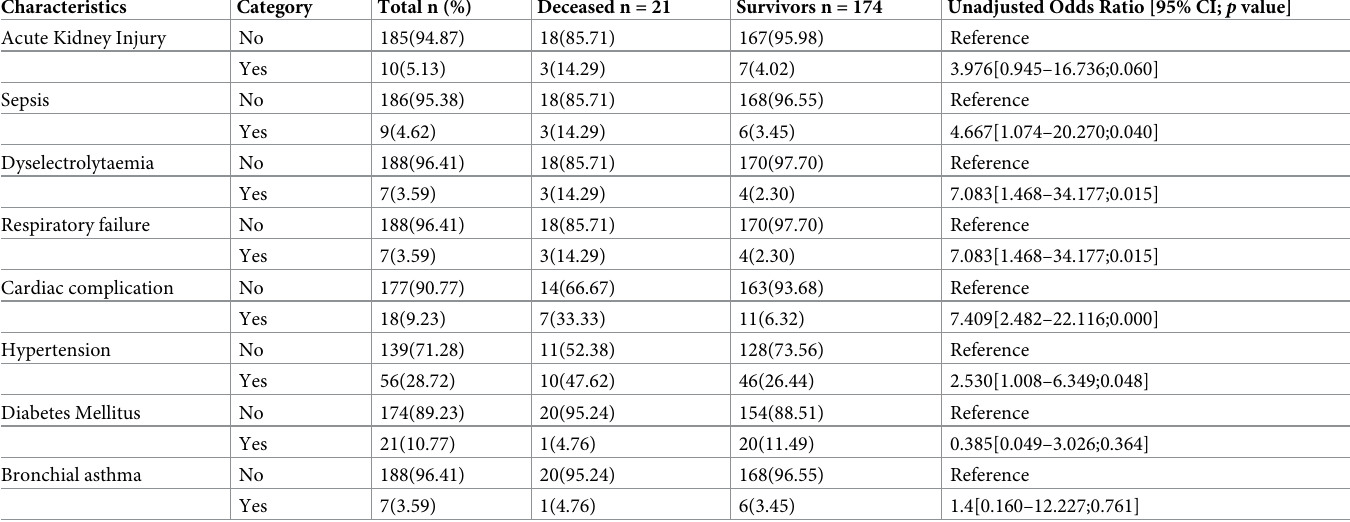
Table 3. Comorbidities, complications and univariate analysis of mortality risk factors of COVID-19 patients (N = 195) at Kwanar Dawaki isolation center, Kano, Nigeria.